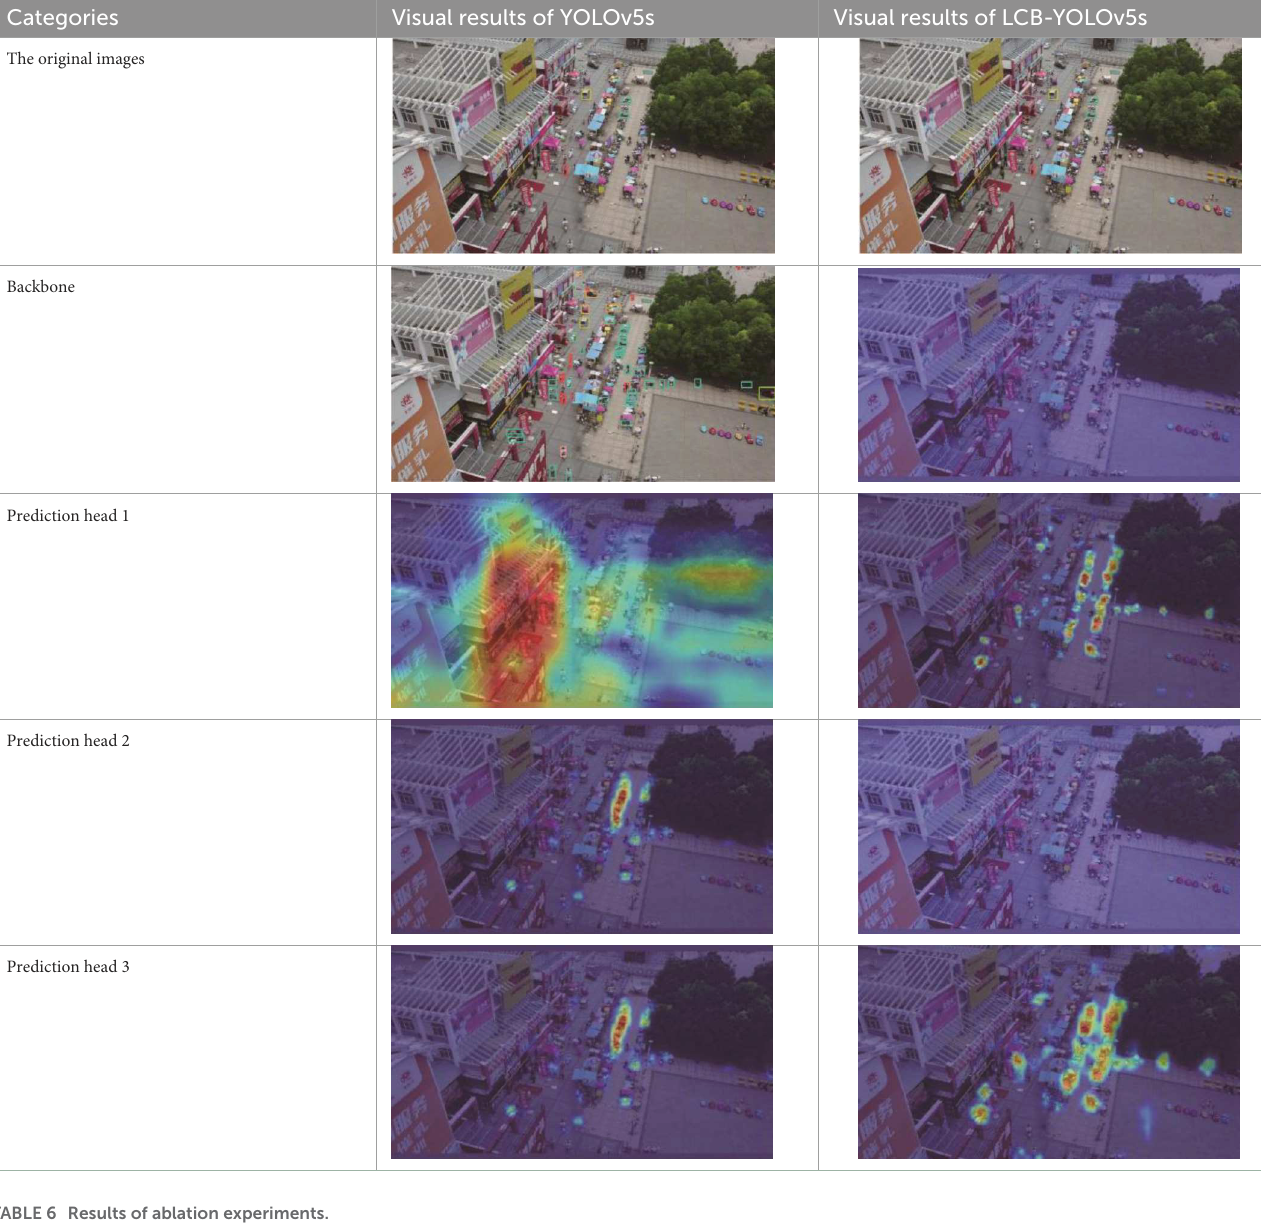
TABLE 5 Visual results of the small target detection on Visdrone2019 dataset.